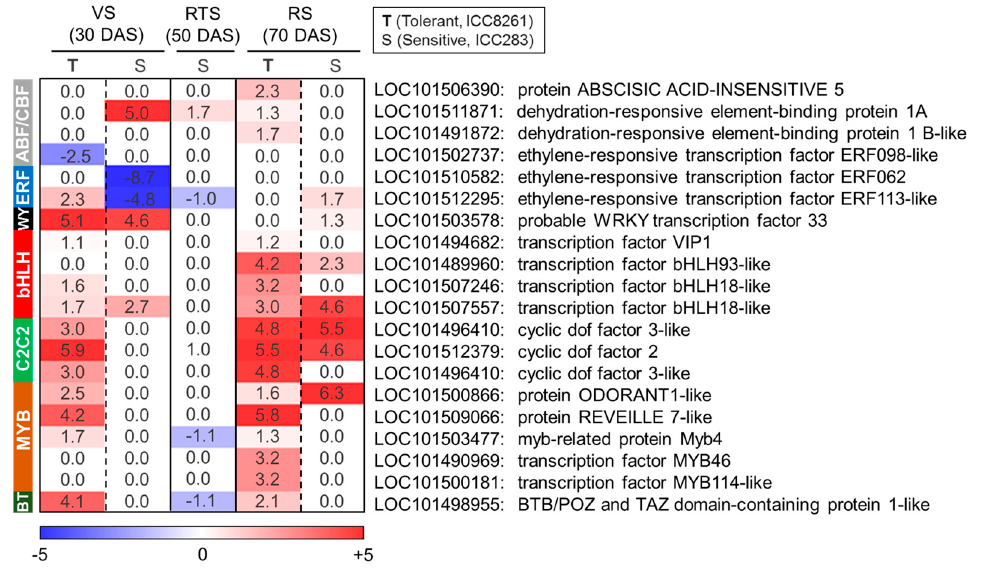
Figure 4. Heat map illustrating differential expression of various transcription factor (TF) gene families in the tolerant (T, ICC8261) and sensitive genotype (S, ICC283) at vegetative (VS), reproductive transition (RTS) and reproductive (RS) stages. The scale color represents log2 fold change.